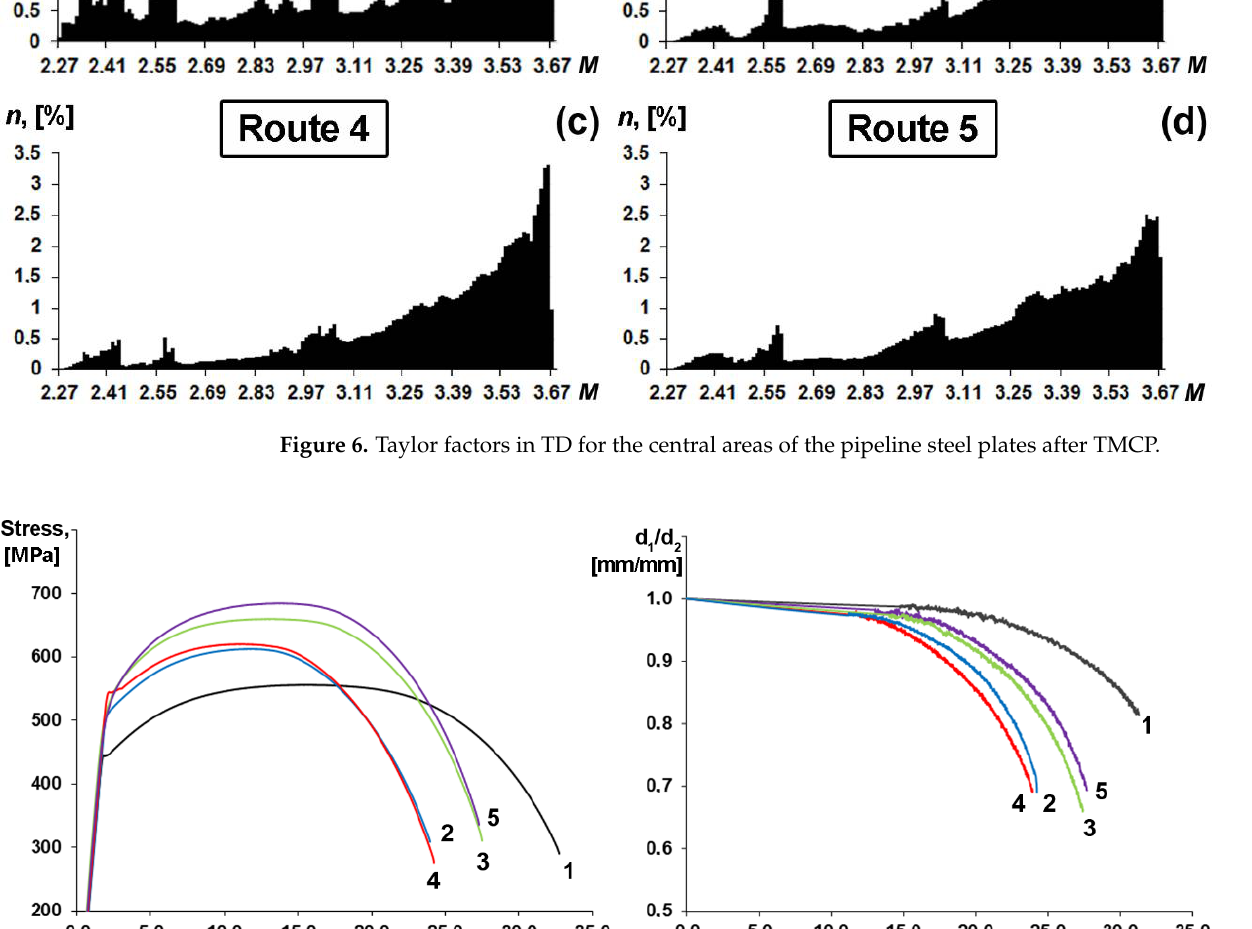
Figure 7. Stress–strain curves of the pipeline steel specimens after different TMCP routes ( a ) variation of elliptic semi-minor axis to semi-major axis ratio in specimen reduced cross-sections after tensile testing ( b ). Specimen axis was parallel to TD.